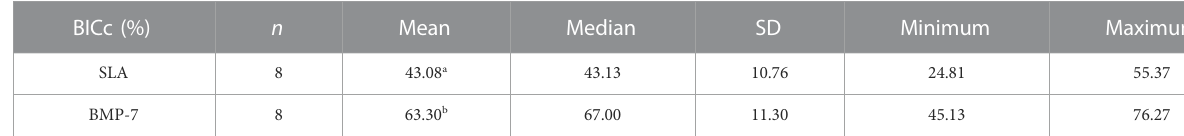
TABLE 2 Descriptive statistics of the BICc (%) histomorphometric parameters.